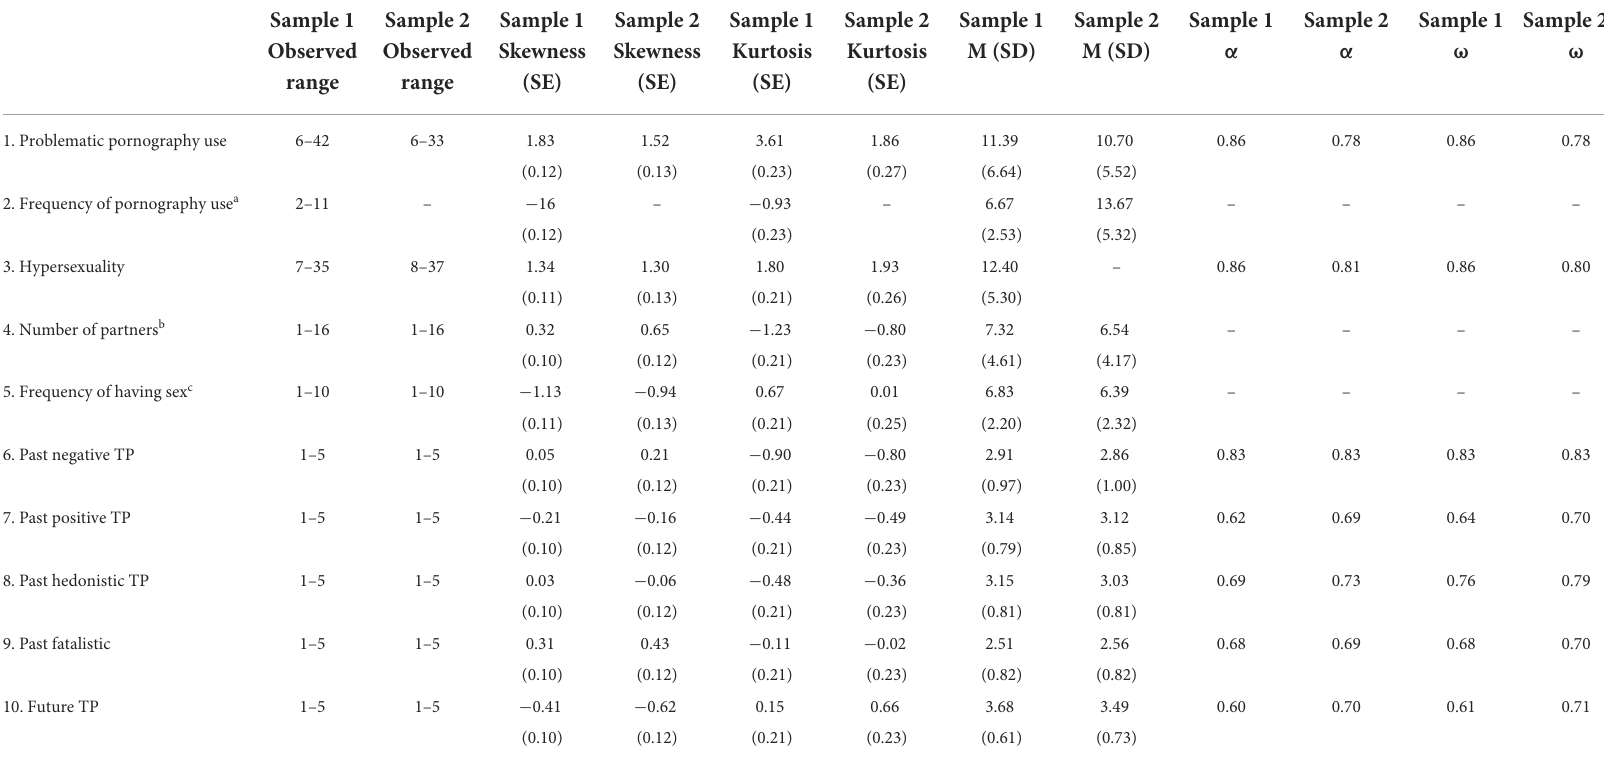
TABLE 1 Descriptive statistics, reliability indices, and correlations between time perspectives, problematic pornography use, frequency of pornography use, hypersexuality, number of sexual partners, and frequency of having sex in Sample 1 and Sample